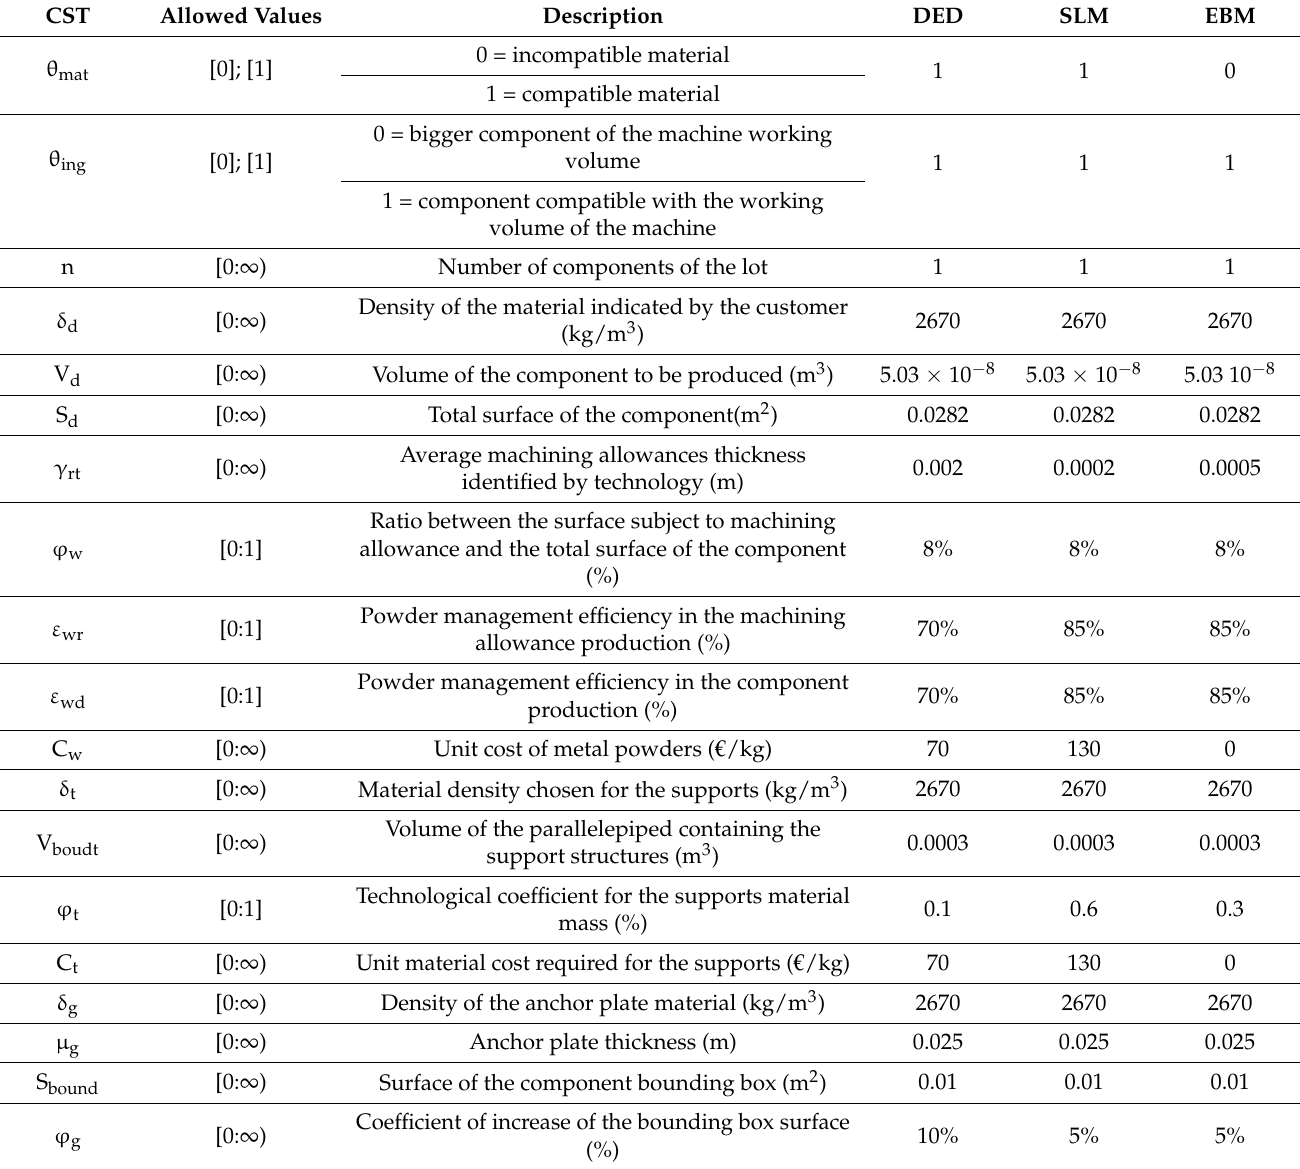
Table 8. CST calculation for the FDM head for traditional